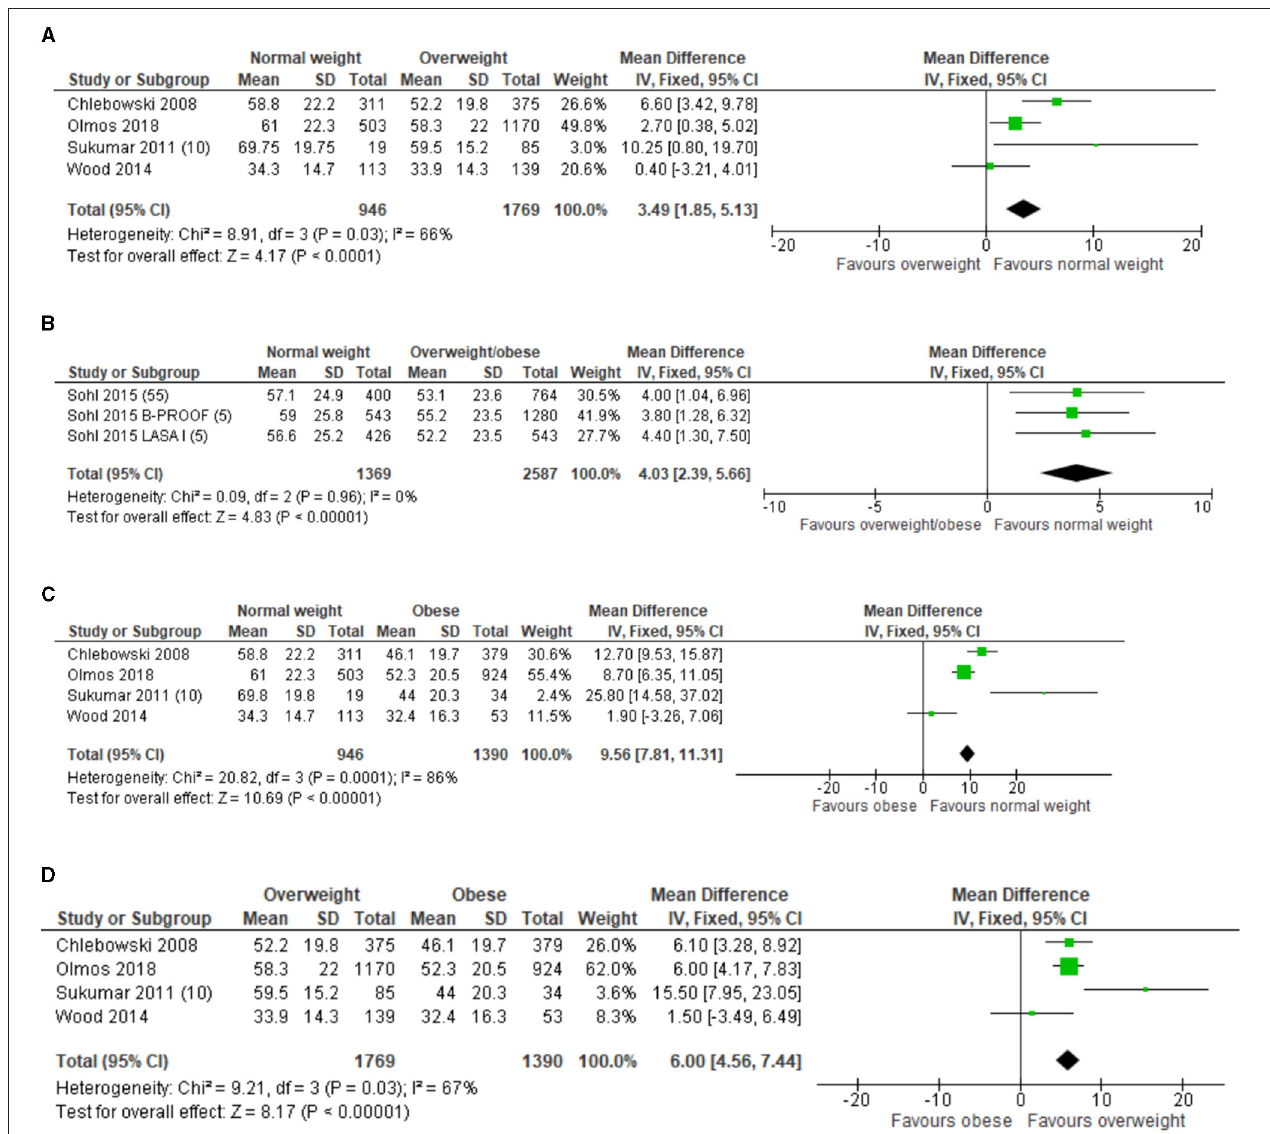
FIGURE 6 | (A) Forest plot of included studies on 25(OH)D concentrations (nmol/L) in older adults between BMI categories overweight compared to normal weight. SD, standard deviation; IV, inverse varience; CI, confidence interval. (B) Forest plot of included studies on 25(OH)D concentrations (nmol/L) in older adults between BMI categories overweight/obese compared to normal weight. SD, standard deviation; IV, inverse varience; CI, confidence interval. (C) Forest plot of included studies on 25(OH)D concentrations (nmol/L) in older adults with between BMI categories obesity compared to normal weight. SD, standard deviation; IV, inverse varience; CI, confidence interval. (D) Forest plot of included studies on 25(OH)D concentrations (nmol/L) in older adults with between BMI categories overweight compared to obesity. SD, standard deviation; IV, inverse varience; CI, confidence